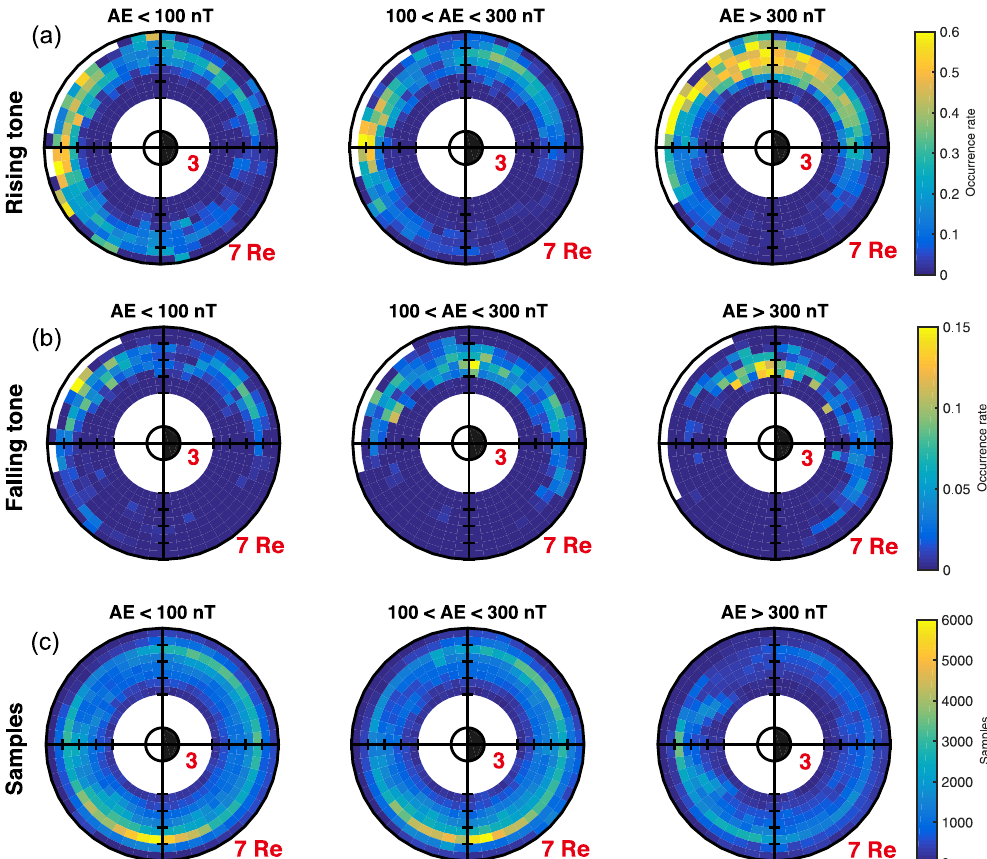
Figure 2. Spatial distribution of the occurrence rate of rising-tone (a) , falling-tone (b) chorus, and the number of samples (c) in MLT– L coordinates categorized by different AE